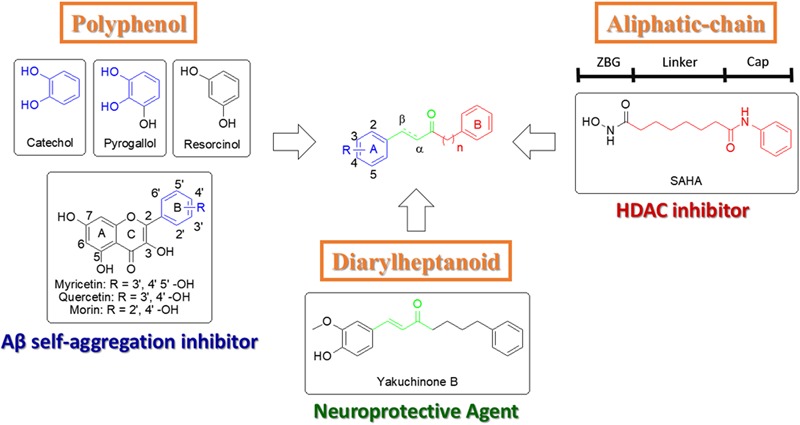
Design strategy for new catechol-modified diarylheptanoid derivatives.